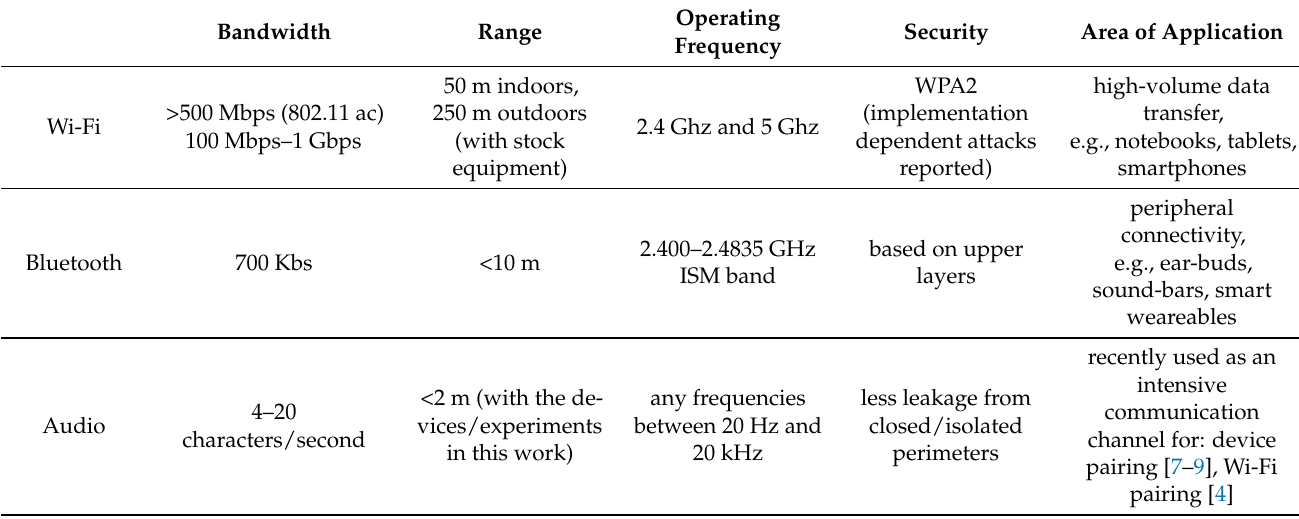
Table 1. Comparison with others wireless communication methods inside vehicular